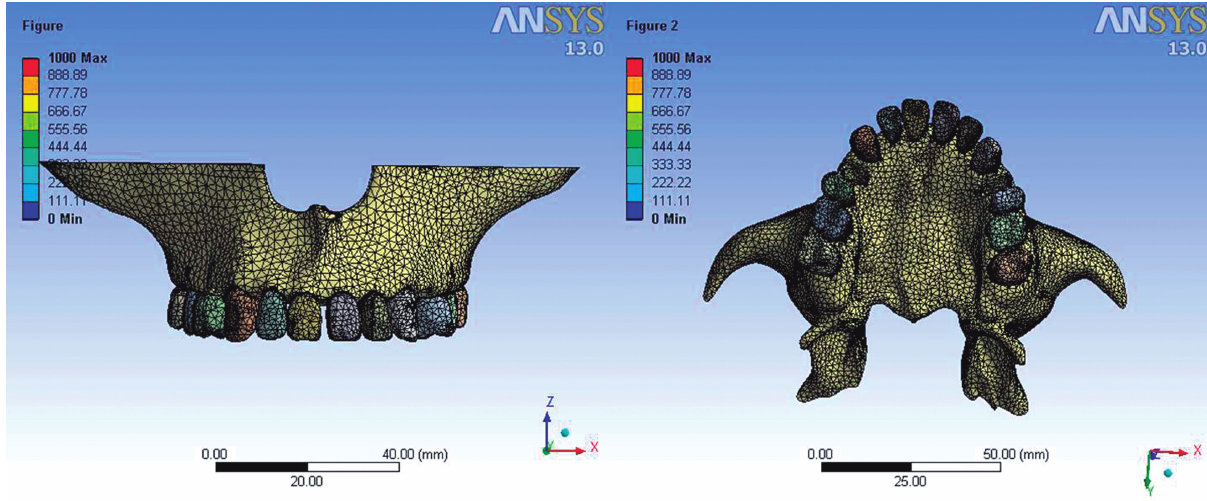
Figure 1- The initial 3D finite element model of the maxilla and the maxillary